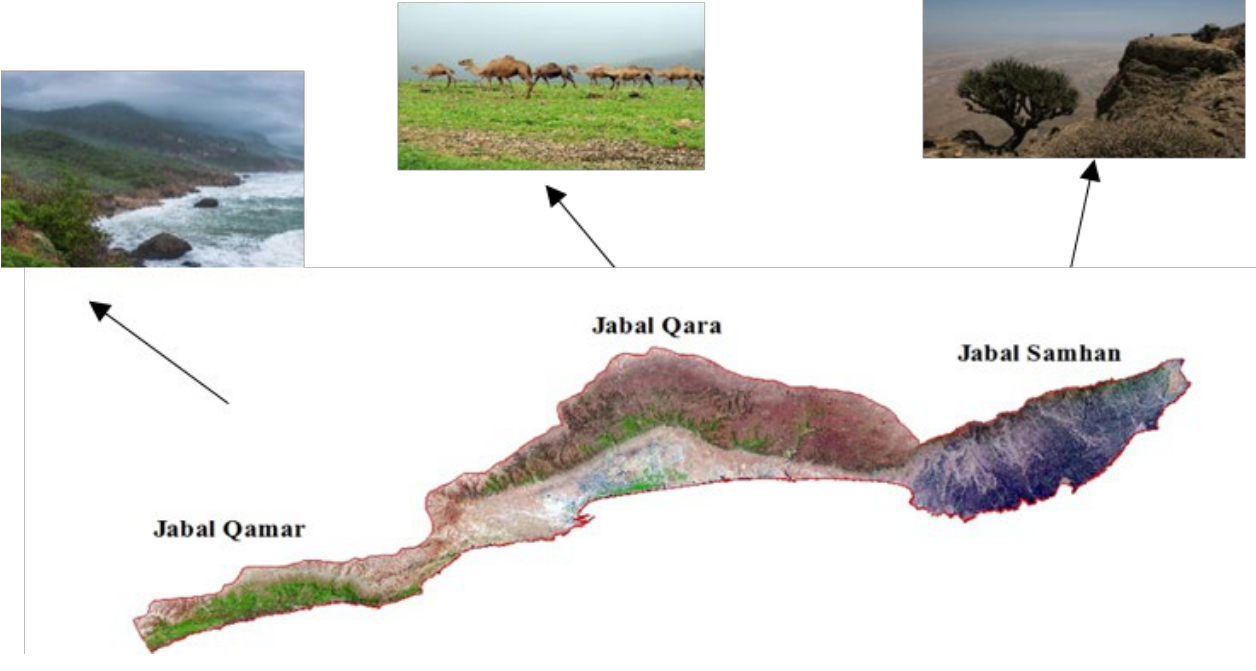
Figure 12. Climatic factors have a varied influence on the response of vegetation dynamics in the areas of the Dhofar Governorate.